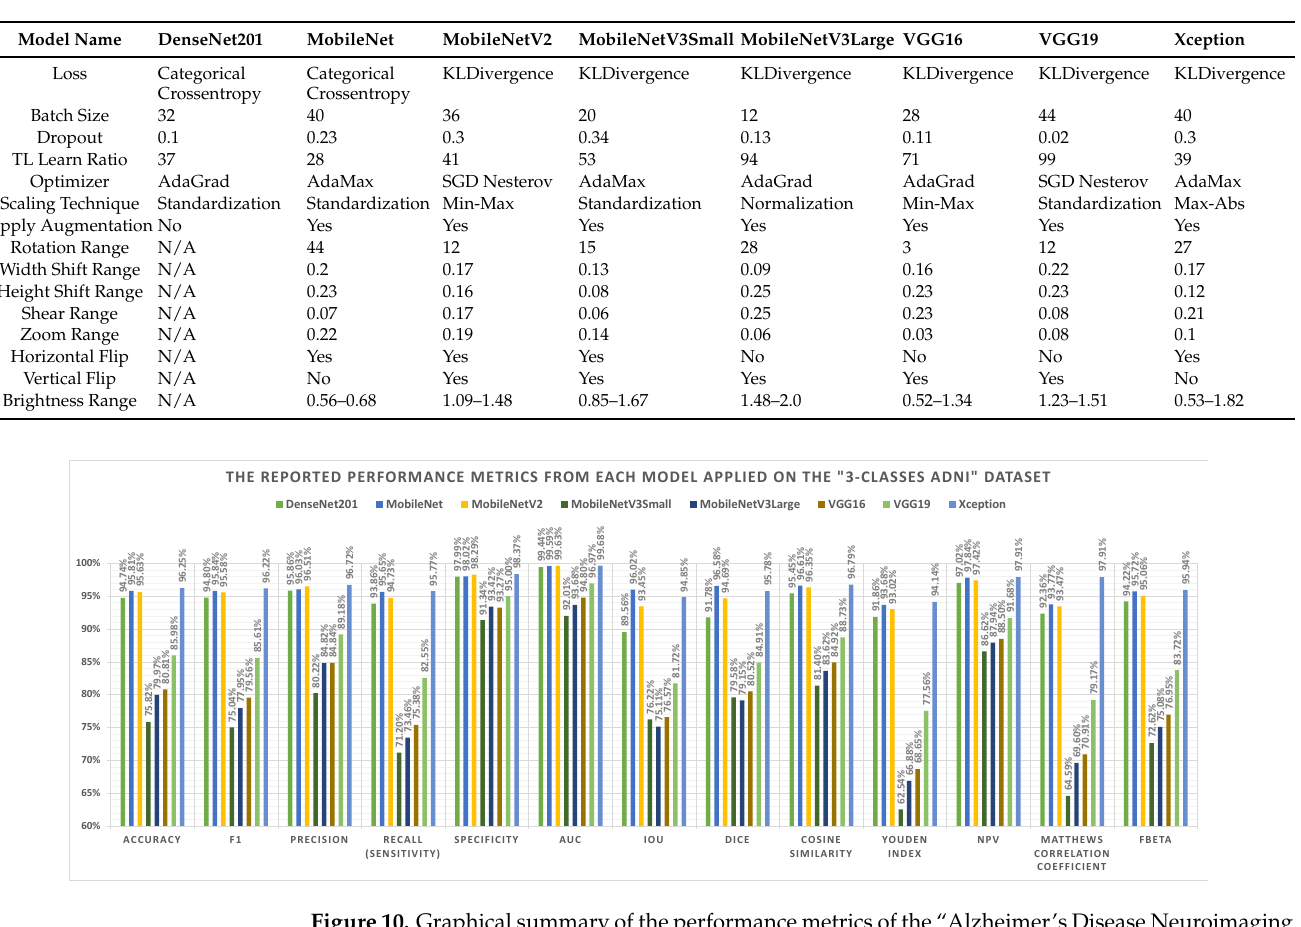
Figure 10. Graphical summary of the performance metrics of the “Alzheimer’s Disease Neuroimaging Initiative (ADNI)” dataset.